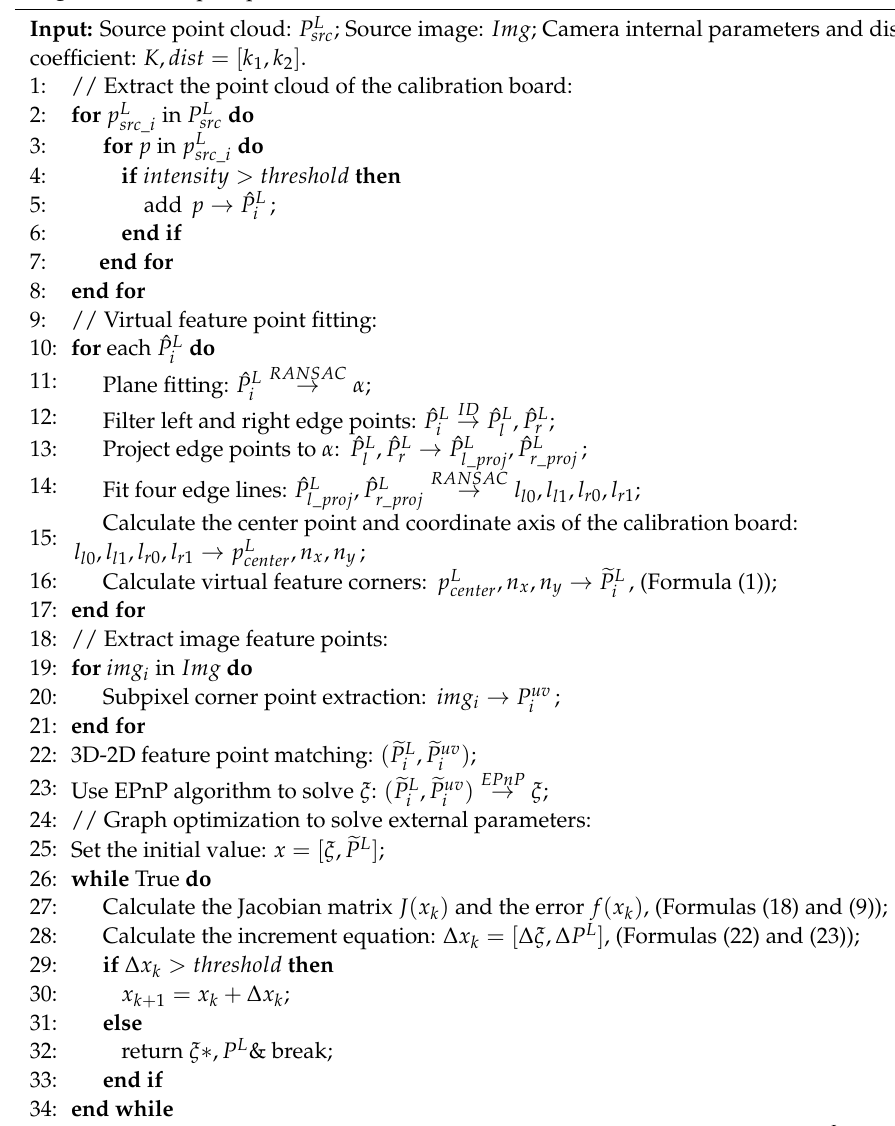
Algorithm 1 Graph Optimization Calibration of